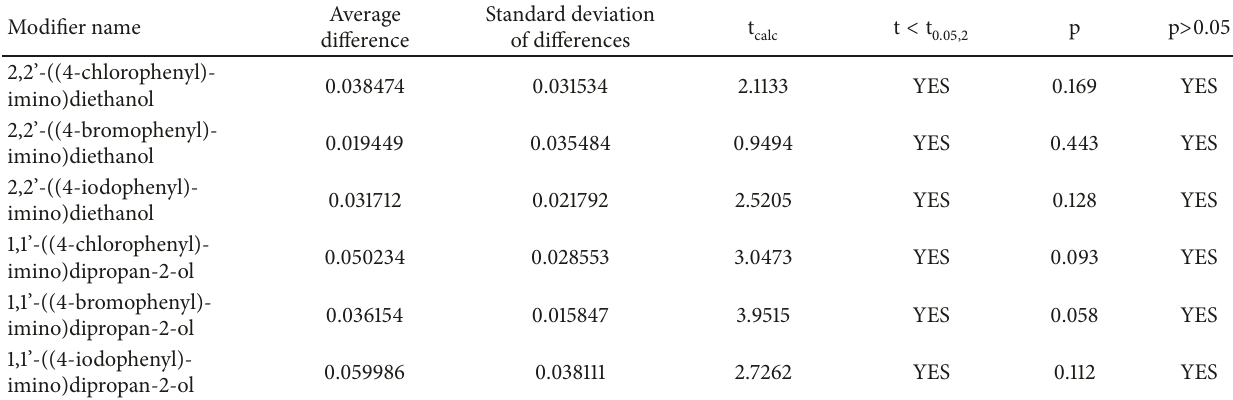
Table 3: Statistical parameters calculated using Student’s